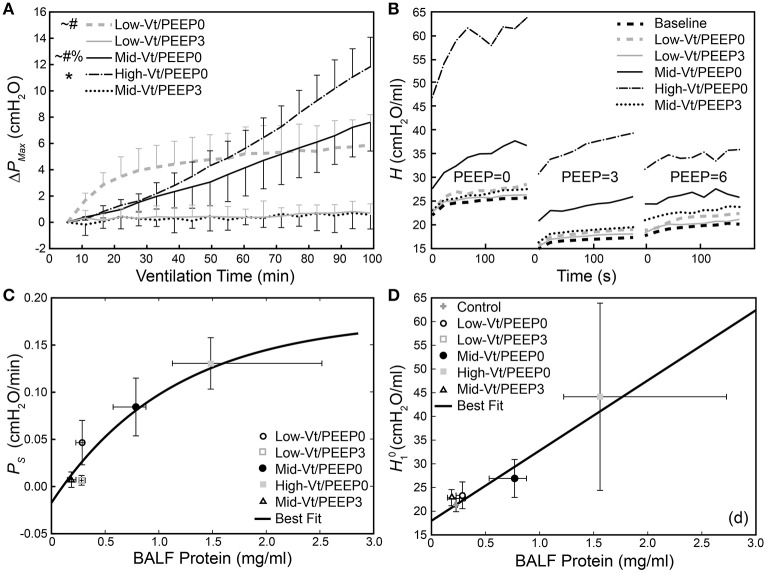
(A) Change in dynamic pressure-volume loop peak pressure (ΔPMax) during ventilation. *Indicates that the rate of increase of ΔPMax (PS) was significantly greater than all other groups; significant increases from Mid-Vt/PEEP3 (#), Low-Vt/PEEP3 (~), and Low-Vt/PEEP0 (%). Error bars show standard deviation. (B) Changes in derecruitment dynamics at PEEP = 0, 3, and 6 cm H2O caused by mechanical ventilation. The statistical significance of intra-group elastance changes over the course of ventilation are shown in Table 2, intra-group differences in elastance at different derecruitment test PEEPs are shown in Table 3, and post-ventilation inter-group elastance changes are shown in Supplementary Tables 2–4. (C)
PS increases as a function of BALF total protein [y = 0.18(1 – e−0.89(x-0.10)), R2 = 0.81, p < 0.027, black line]. (D) Increase in initial elastance during the PEEP = 0 derecruitability test (H10) at the conclusion of the experiment is correlated with increased BALF total protein (y = 18.0 + 14.1x, R2 = 0.78, p < 10−18). Data points for H10 and PS show the mean with error bars showing standard deviations; data points for BALF protein show the median with error bars showing the interquartile range.